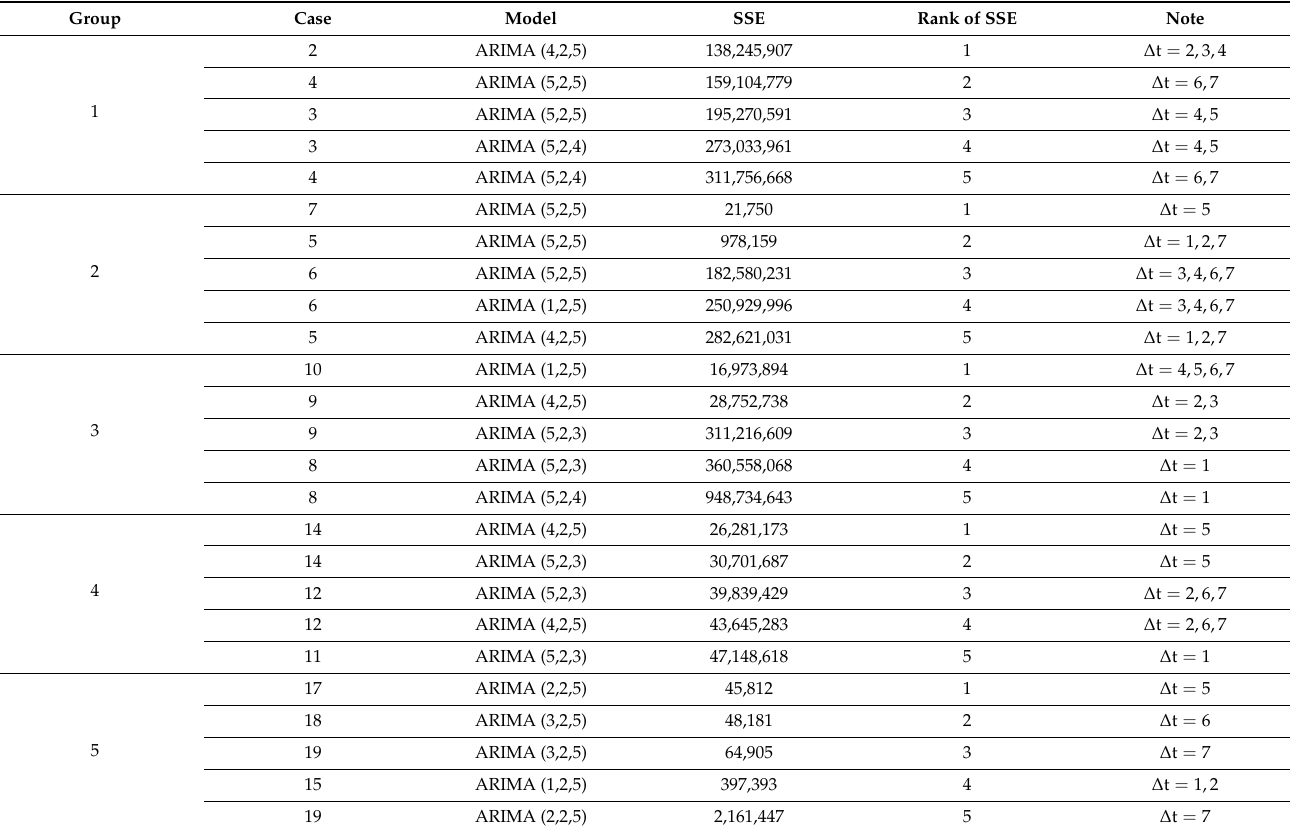
Table 8. Results of ARIMA models for each group and case based on